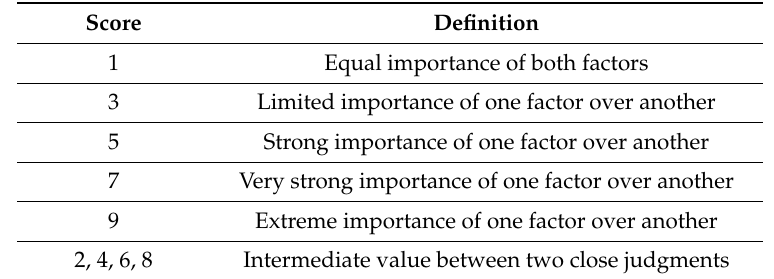
Table 1. Scales in pairwise comparisons